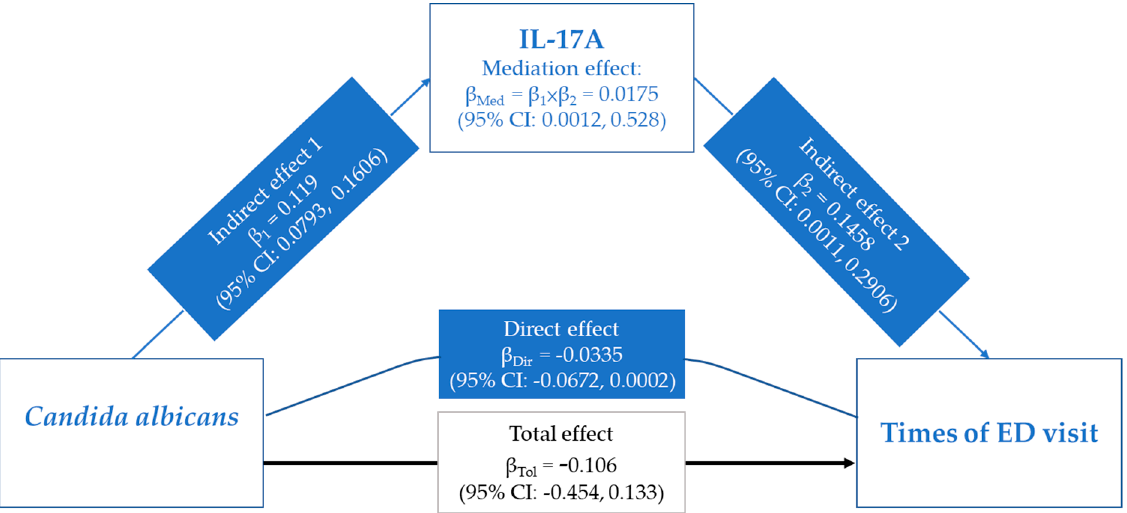
Figure 4. The contribution of IL-17A for the association between Candida albicans and ED visits. Single mediation models and regression coefficients ( β ), with 95% confidence intervals (95% CI) examining potential mediators of IL-17A.